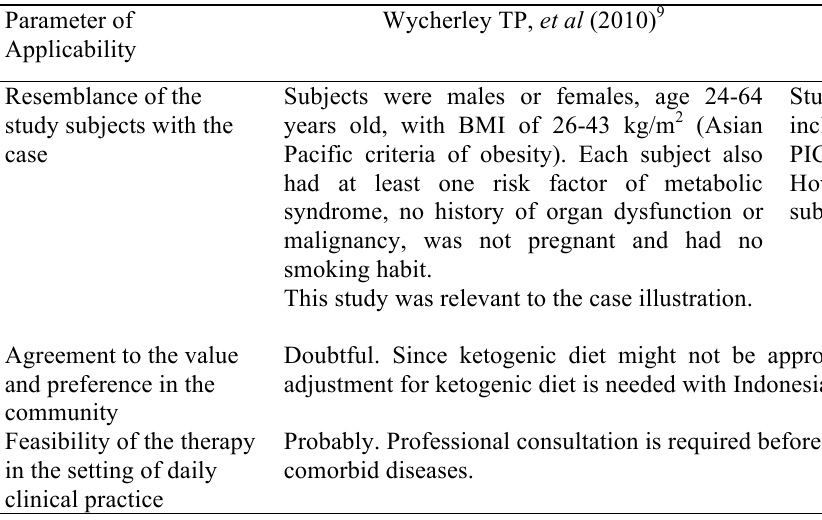
Table 6. Critical appraisal on the applicability of both